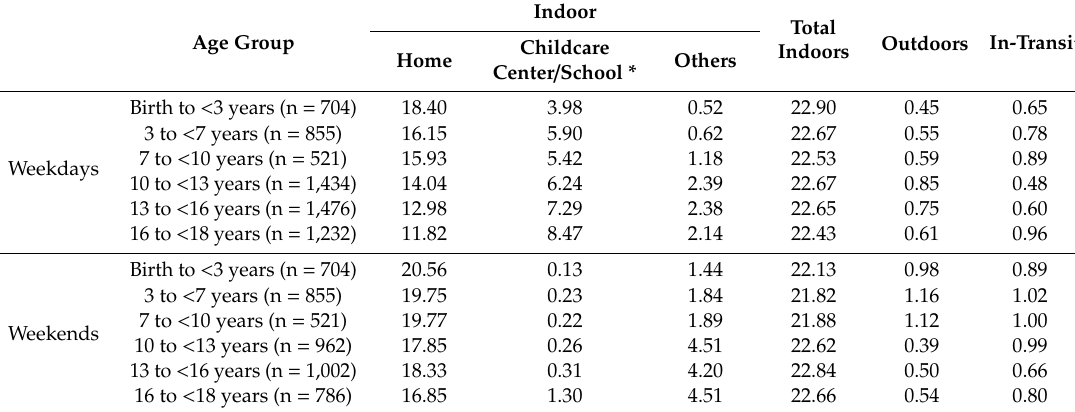
Table 7. Recommended values (hours) for activity factors by weekday and